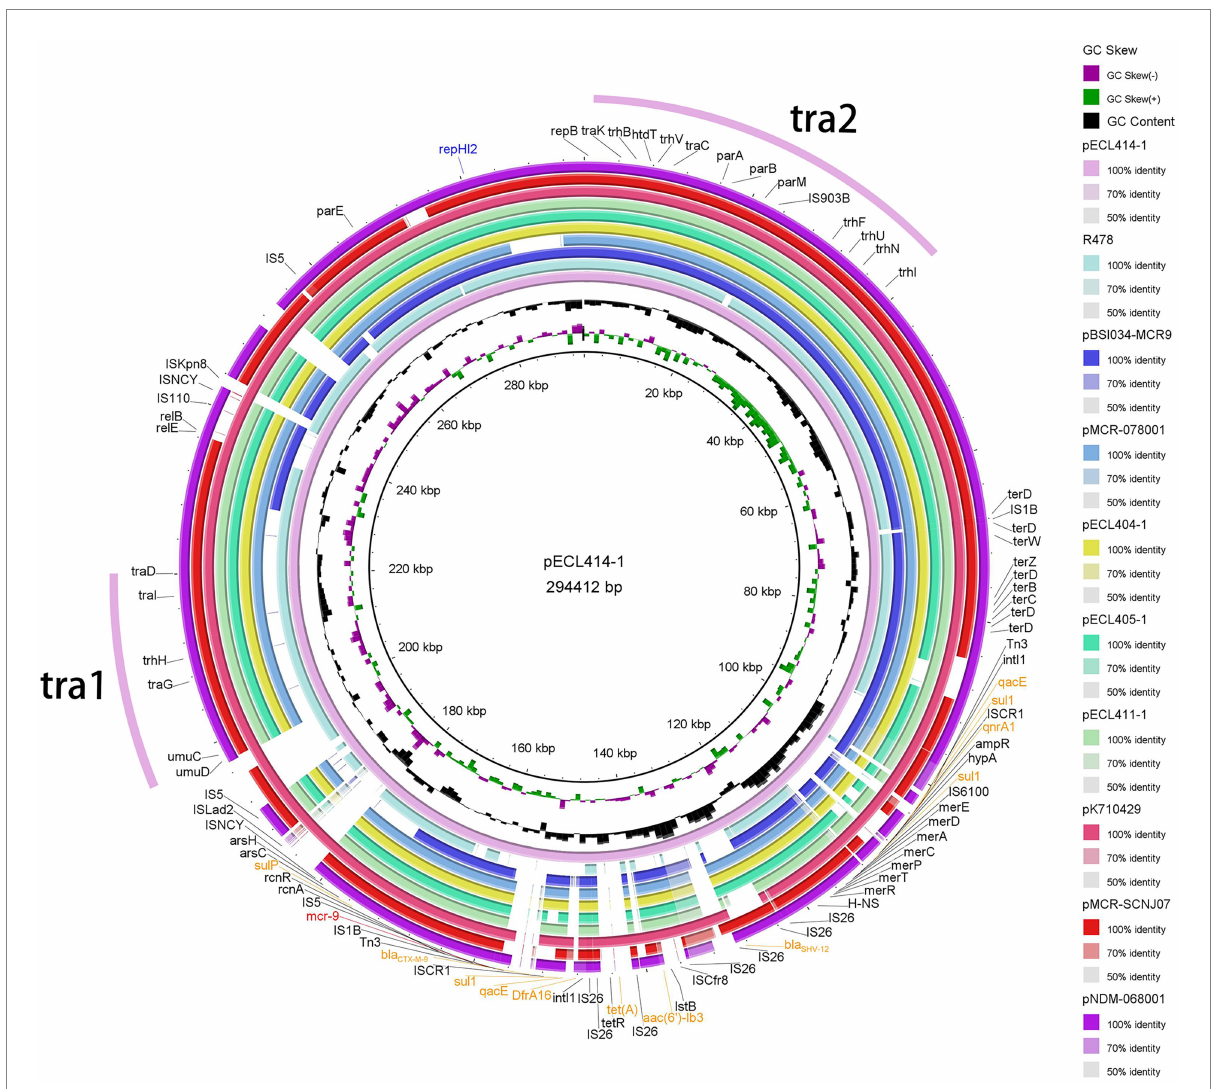
FIGURE 4 Plasmid structure of mcr-9. Sequence alignment of mcr-9 -harboring plasmids pNDM-068001, pMCR-078001, pECL404-1, pECL405-1, pECL411- 1, pECL414-1, pR478, pK710429, pMCR-SCNJ07, and pBSI034-MCR9. The complete plasmid pECL414-1 sequence was used as the reference, and the white and colored regions of the circles indicate absence and presence, respectively. Antibiotic resistance genes are shown in orange ( mcr-9 is shown in red), and the tra1 and tra2 regions for conjugative transfer are indicated by pink curves on the outer